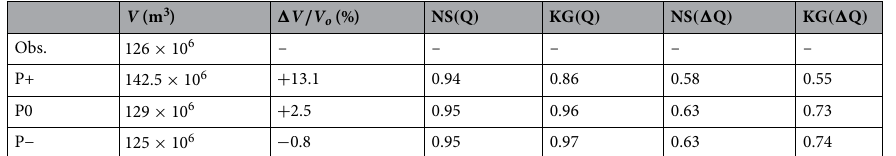
V ( m 3 ) � V / V o ( % ) NS ( Q